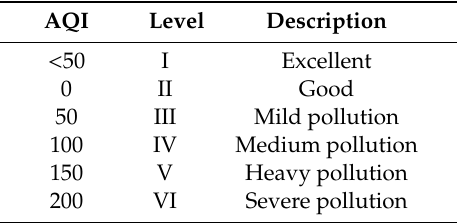
Table A2. Classification threshold for air quality index.